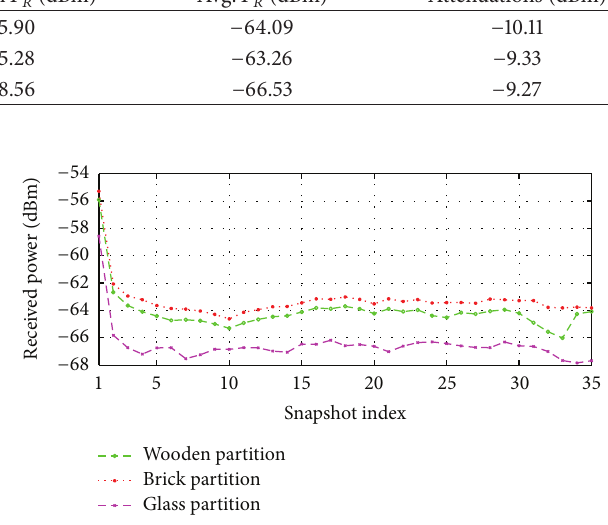
Figure 15: Effect of AP movement on received power when the results taken by considering the inside partitions (red colored) are made of either brick, wood, or glass.